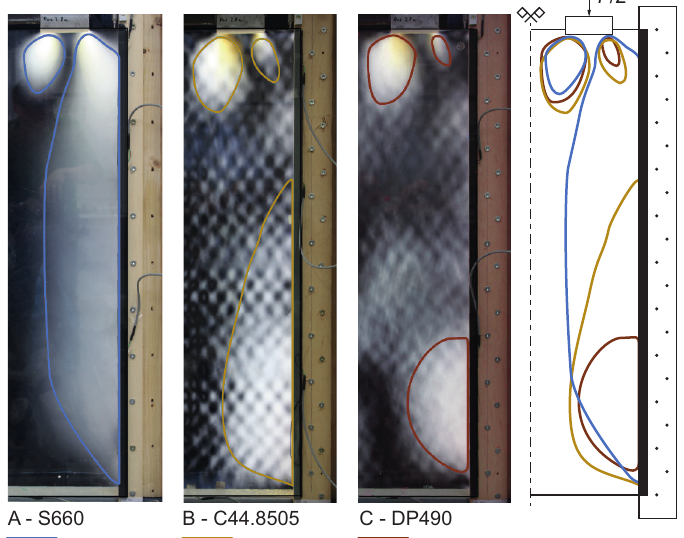
Fig. 10 Images of the backlit glass pane (right half) taken with a polarizing filter, specimen loaded by 20